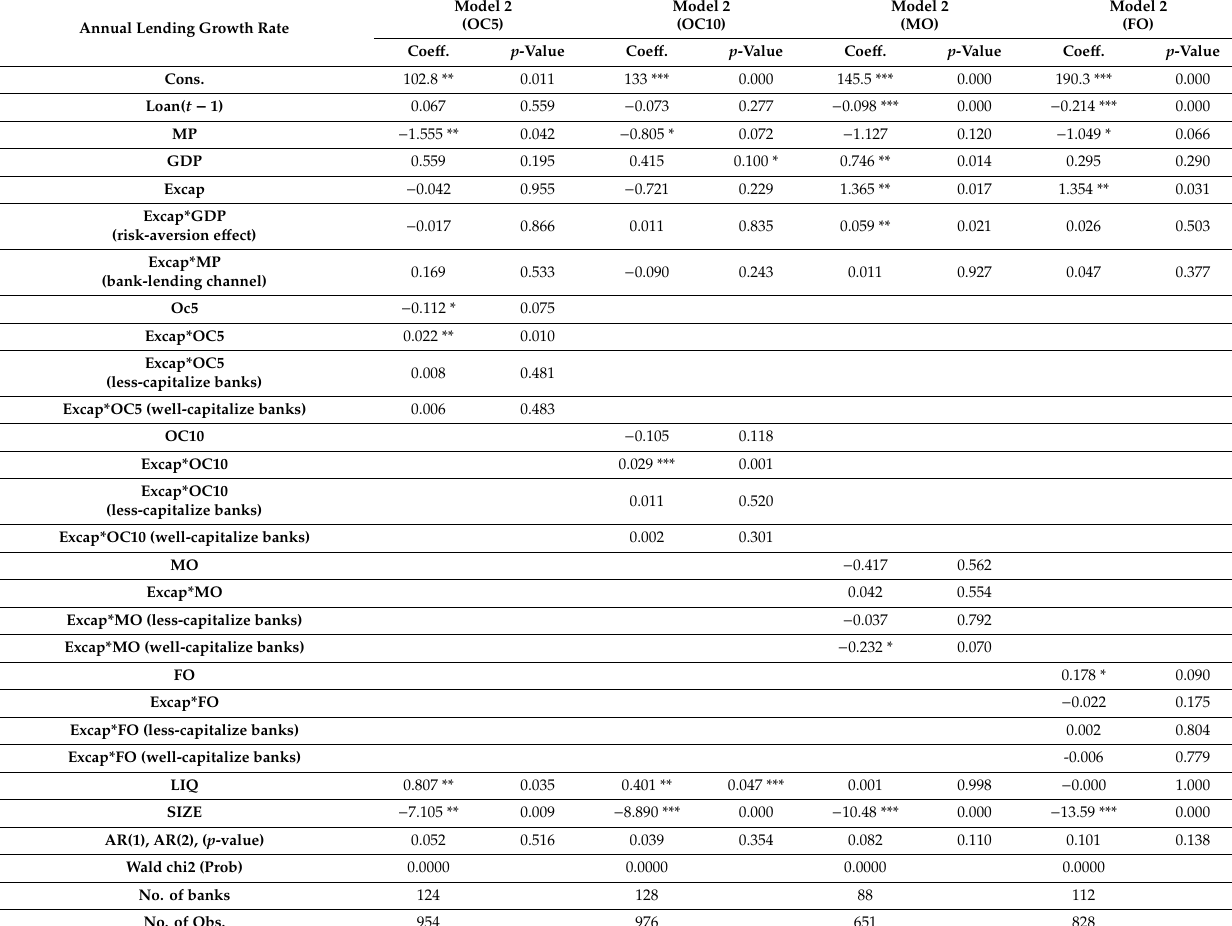
Table 4. Ownership Model